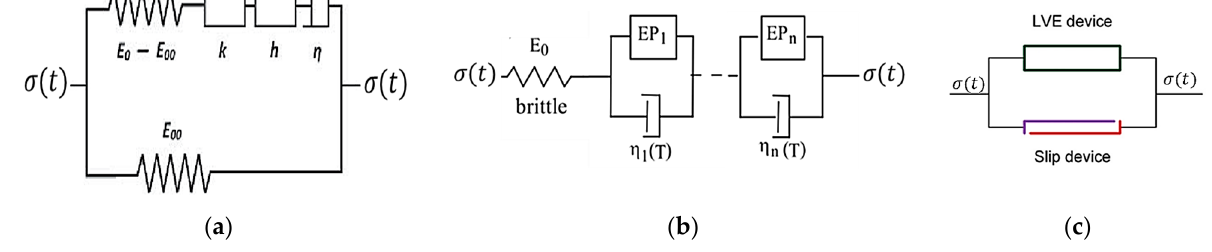
Figure 7. ( a ) The 2S2P1D rheological model (h and k are two parabolic creep elements), ( b ) DBN model for bituminous mixtures, and ( c ) slip device for the viscoplastic model with viscoelastic component.